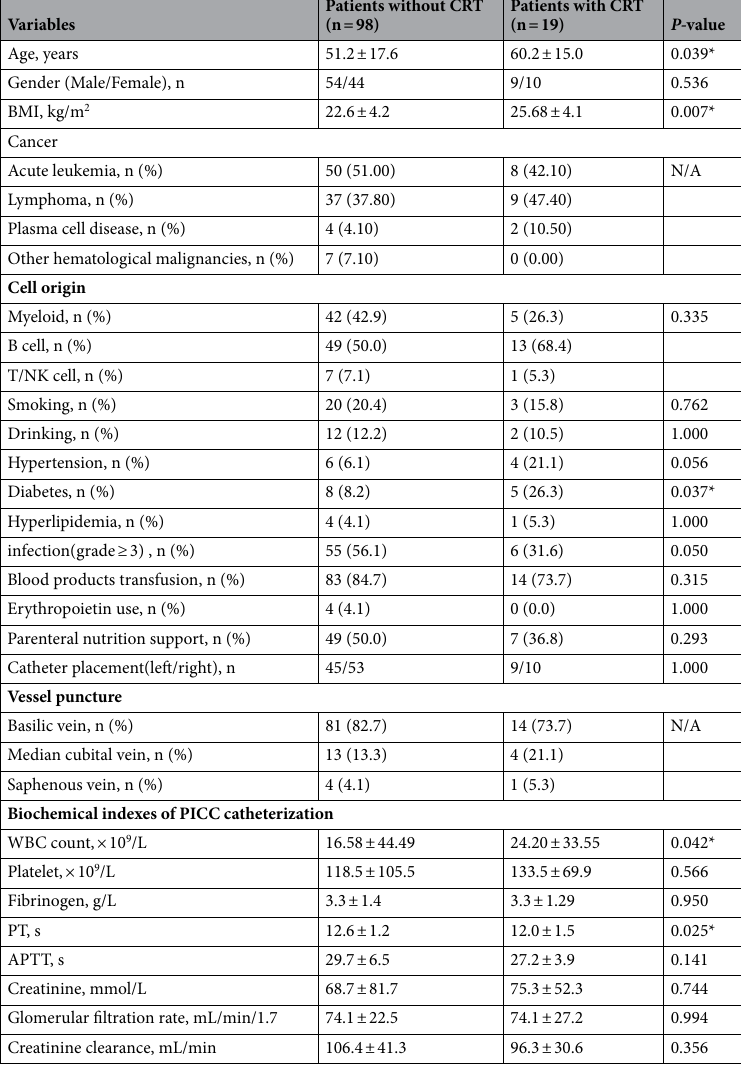
Table 1. Clinical features of hematological malignancy patients with and without CRT. BMI Body mass index, PICC Peripherally inserted central catheter, CRT Peripherally inserted central catheter -related venous thromboembolism, WBC White blood cell, PT Prothrombin time, APPT Activated partial thromboplastin time. *Statistically significant.